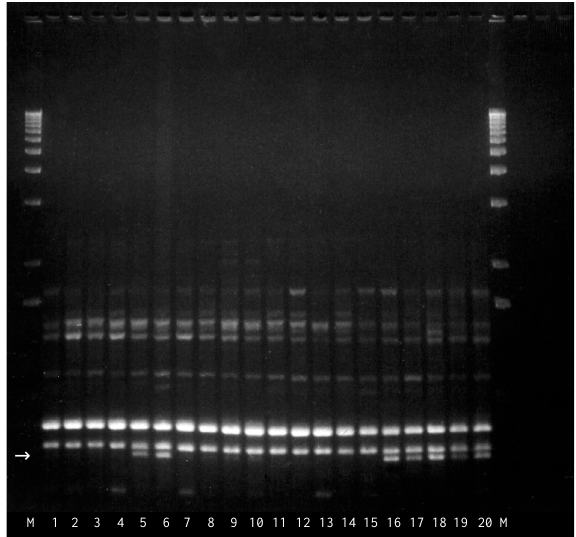
Figure 1 - Electrophoretic analyses of DNA amplification products from M. quadrifasciata colonies with primer OPE-07. Lanes are as follows: M, 1-kb DNA ladder size markers; 1-4, colonies collected in Minas Gerais; 5- 11, colonies collected in Paraná; 12-15, colonies collected in Espírito Santo; 16-20, colonies collected in Santa Catarina. The arrow indicates a DNA band present in M. q. quadrifasciata and absent in M. q. anthidioides